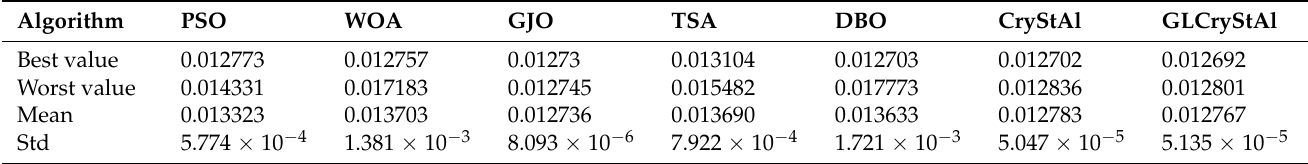
Table 11. The best results of six